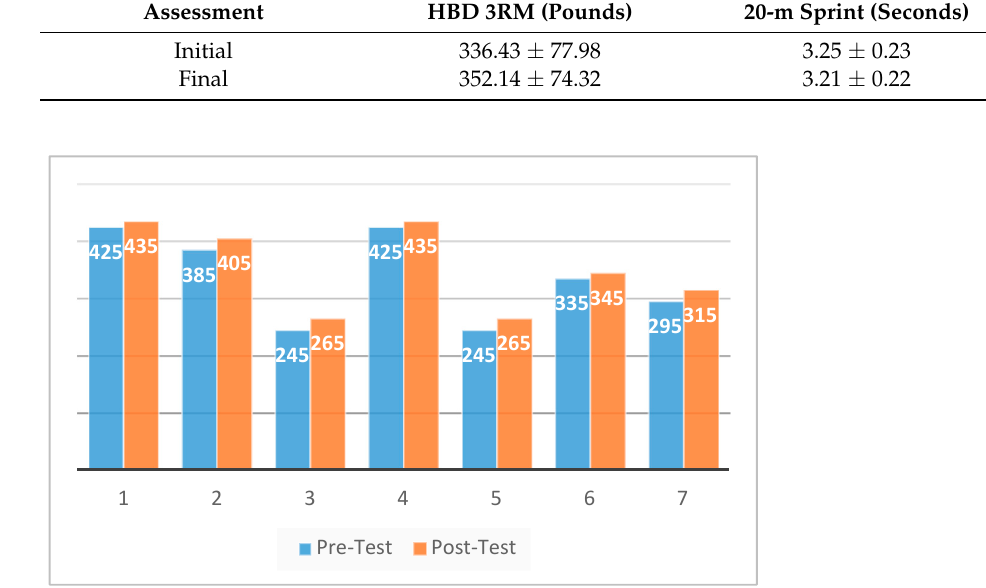
Table 1. Initial and final performance assessment HBD 3RM and 20-m sprint times.